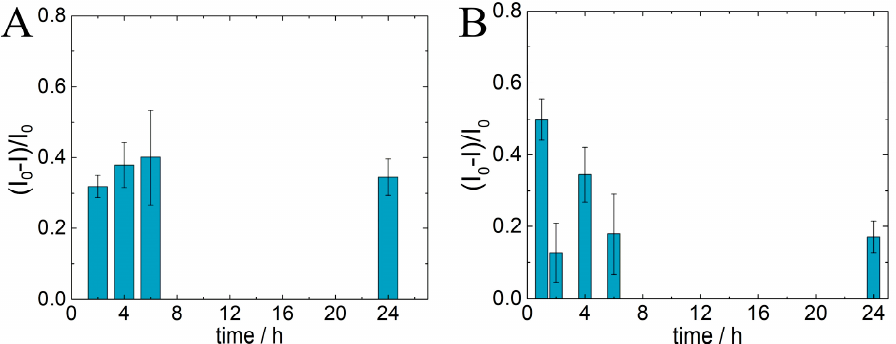
Figure 5. SWV response optimization of the performance of the immunosensor in acetate buffer 1.0 mol·L − 1 (pH 4.75). ( A ) incubation time of IgG-Ab on 6-PICA/GCE. ( B ) incubation time of IgG-Ag on IgG-Ab/6-PICA/GCE.